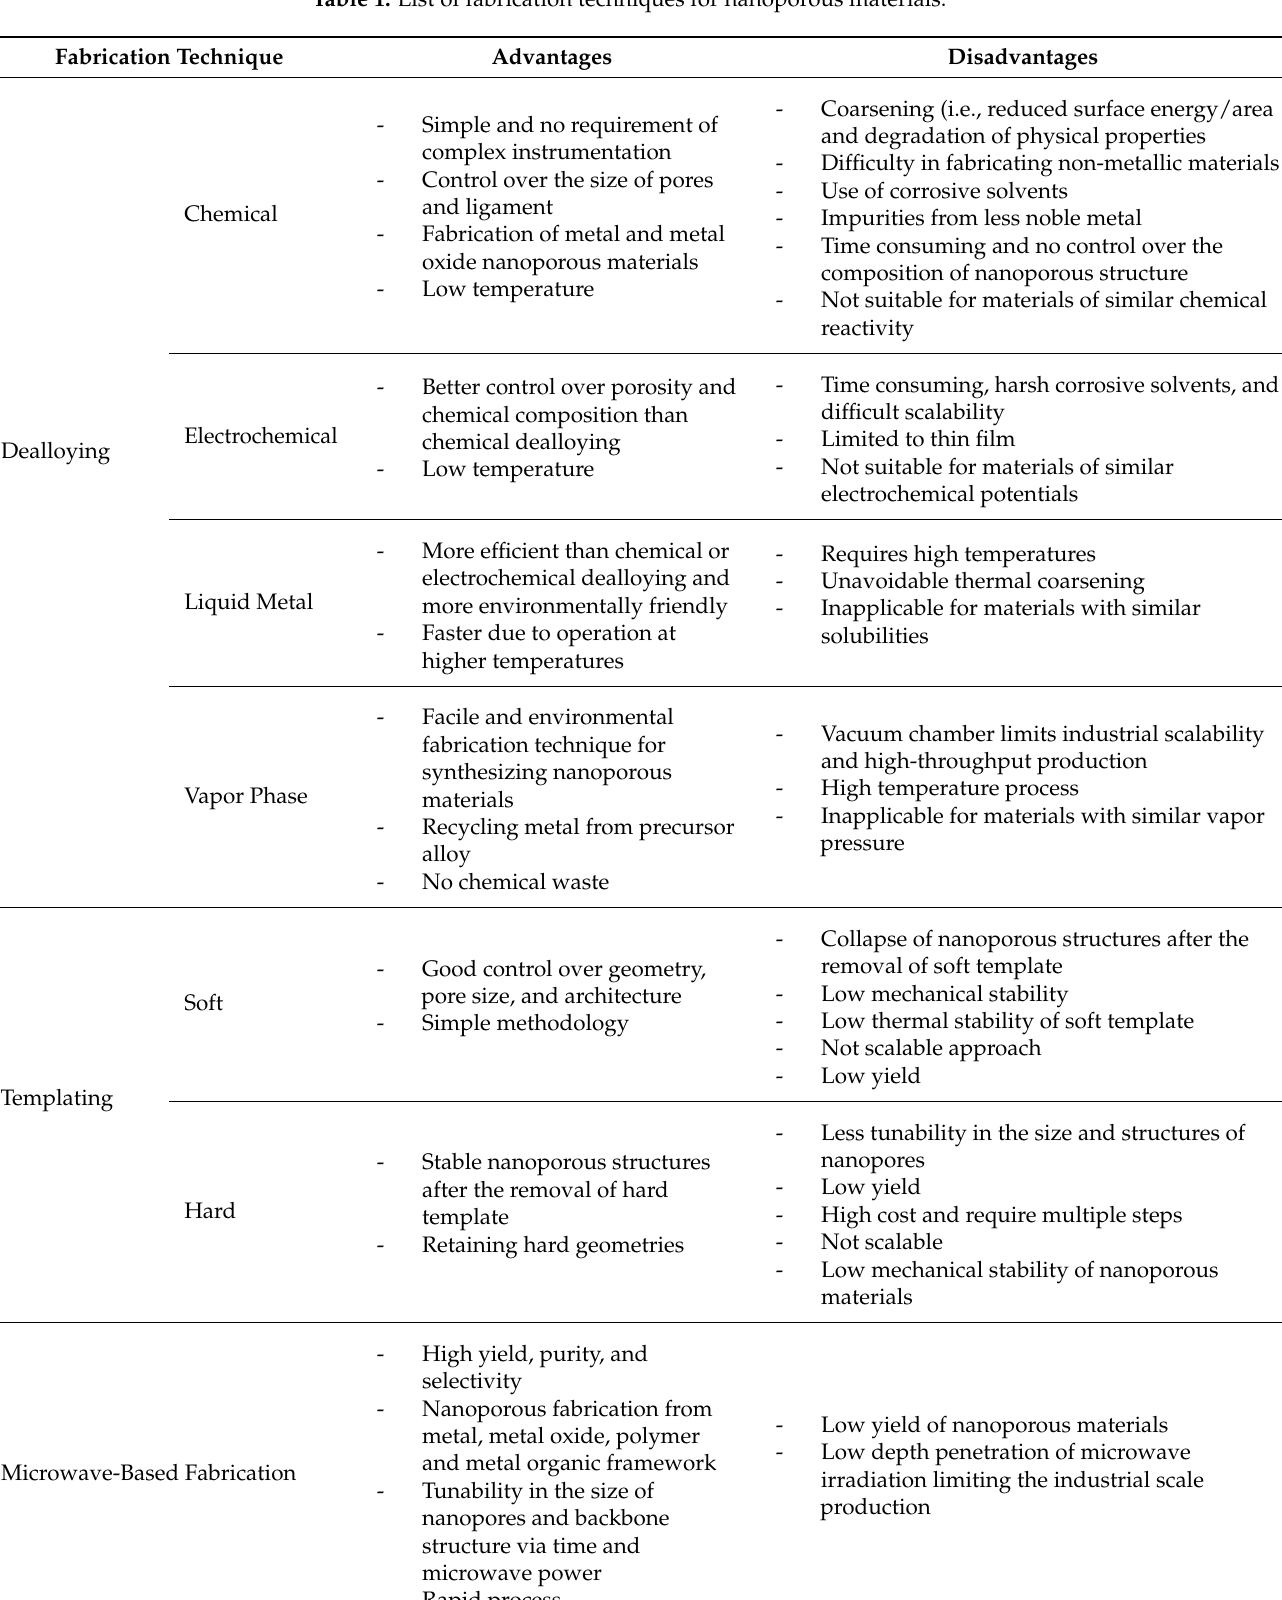
Table 1. List of fabrication techniques for nanoporous